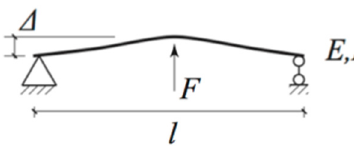
Figure 4. Simple supported beam system with a displacement in the middle.